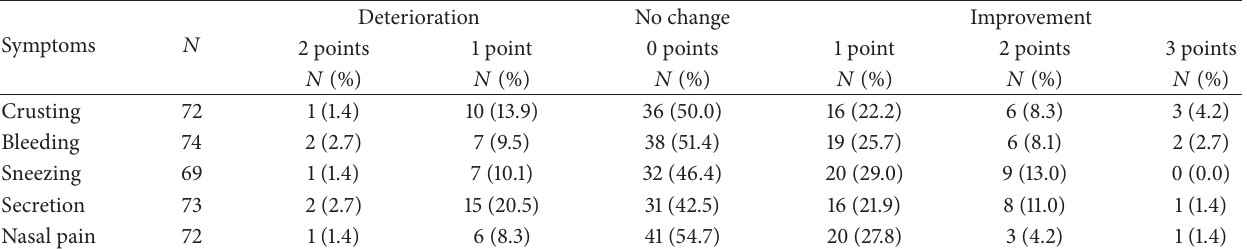
Table 3: Differences between pre- and postoperative scores on the 4-point Likert scales for other nasal symptoms. Symptoms 𝑁